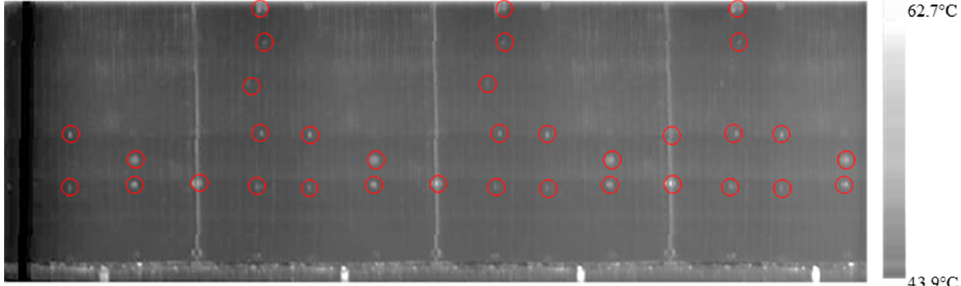
Figure 11. Stitched results of the fixed scan experiment for C100-sample (0.27 rpm & 500 W).